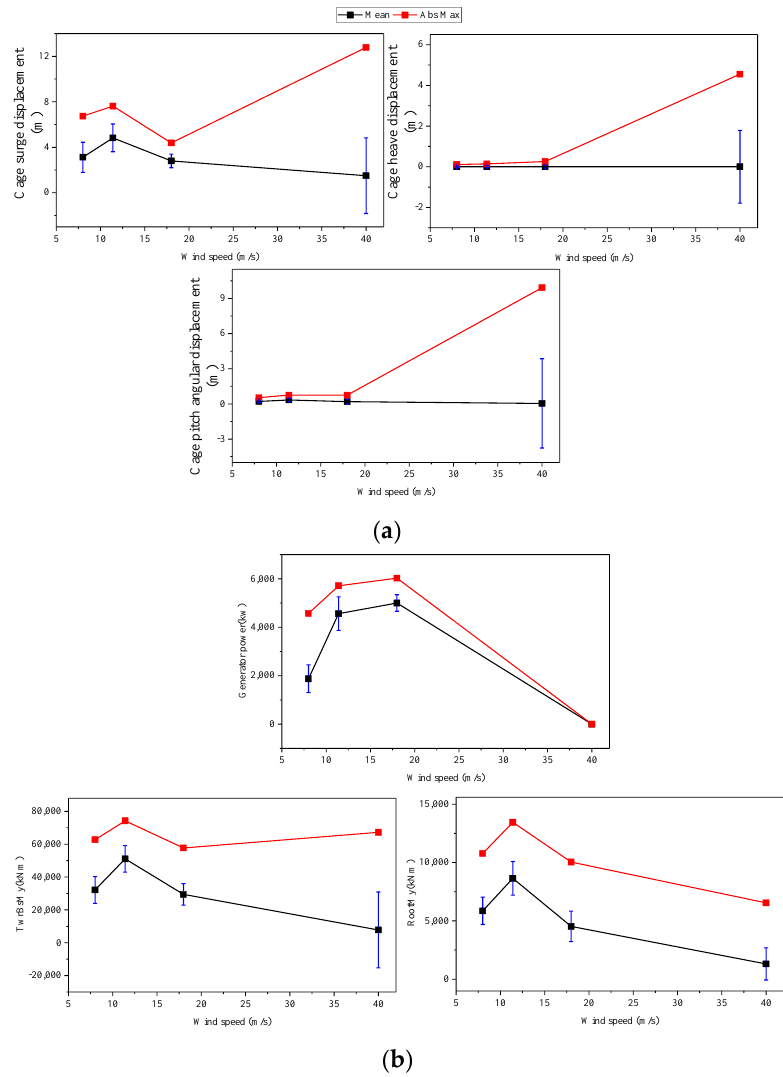
Figure 17. Statistical properties of the cage and wind turbine responses. ( a ) Cage responses. ( b ) Wind turbine responses.